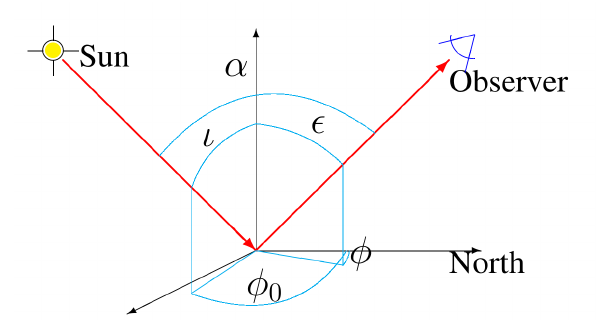
Figure 1. Definition of the angles used in surface reflectance work: (cid:15) and ι are the zenith angles of the emergent (Observer) and incident (solar) radiation, respectively (shorthand µ = cos (cid:15) and µ 0 = cos ι are also used). φ and φ 0 are the corresponding azimuth angles. The phase angle α is the angle between the observer and the Sun. The principal plane is fixed by the solar direction and the surface normal, while the cross plane is a vertical plane perpendicular to the principal